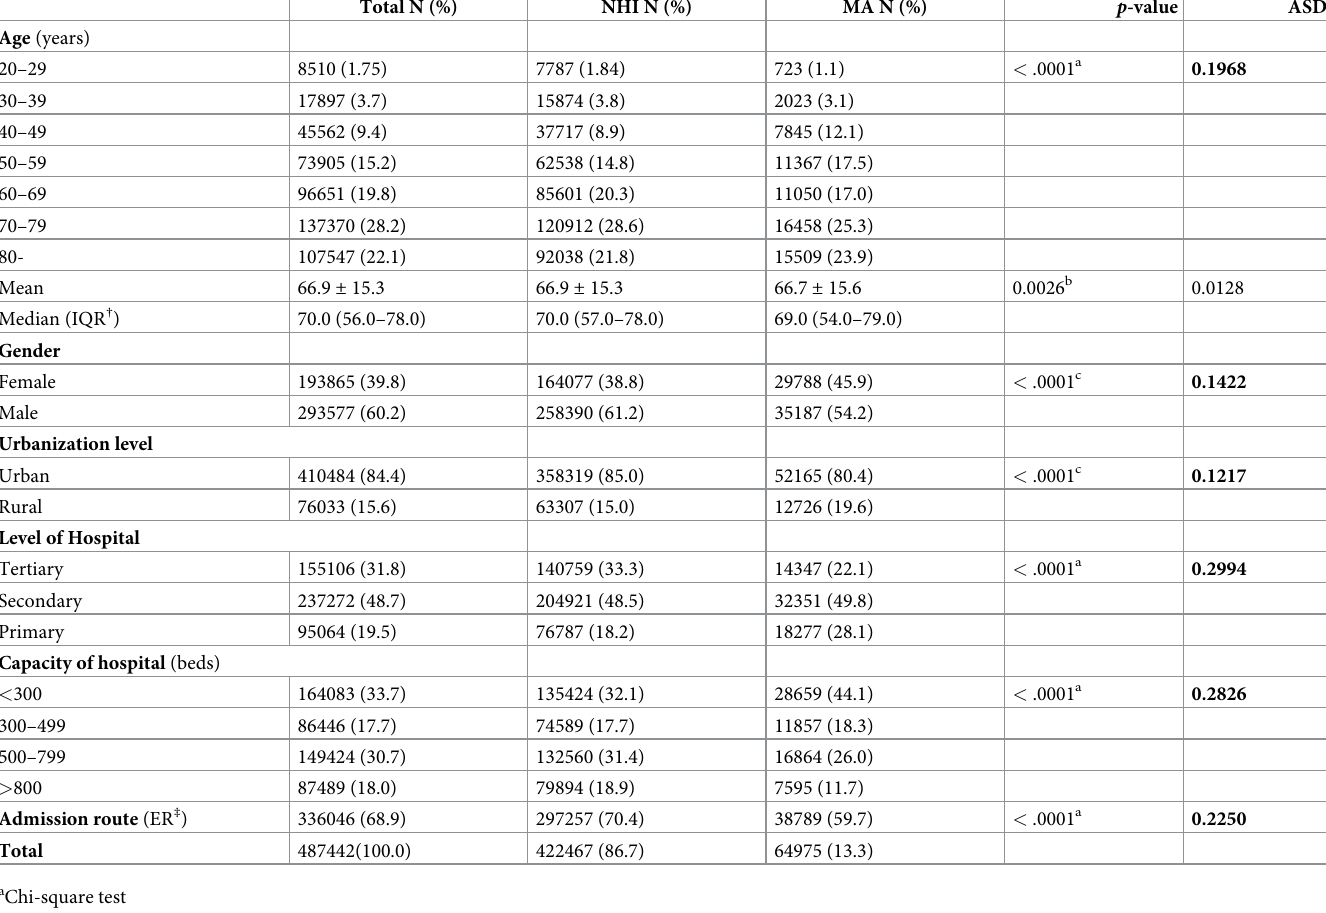
Table 1. Characteristics, and hospital factors in national health insurance group and medical aid